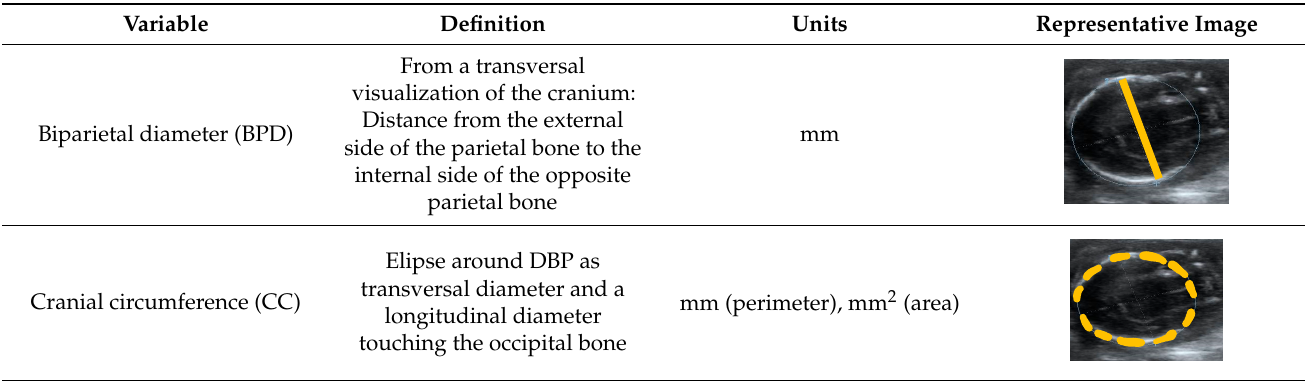
Table 1. Description of the ultrasound measurements made.